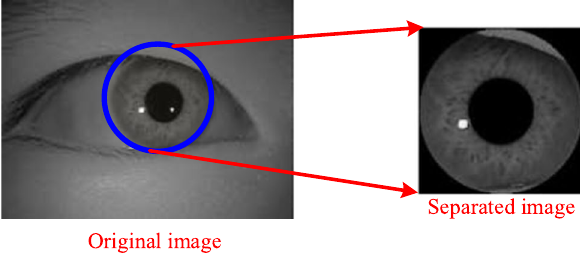
Fig. 5 The structure of the residual network